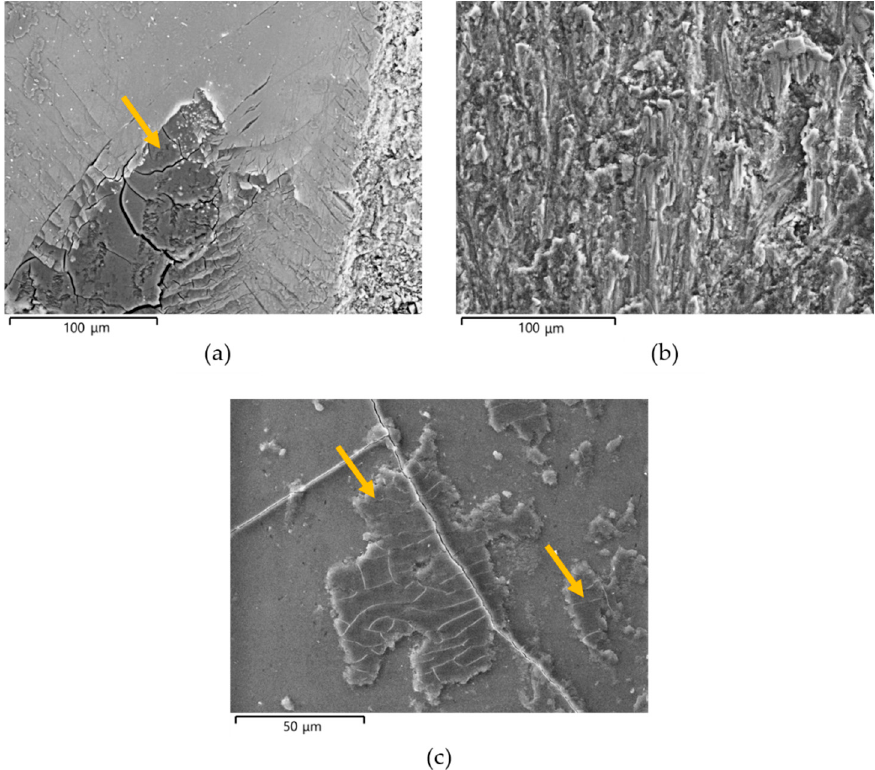
Figure 10. VPSEM images of the worn surfaces of pins after wear tests: ( a ) details of the original surface with metallic film deposition on G_50; ( b ) details of abrasion of the aluminum substrate in GP_50; ( c ) details of metal transfer and microcracks on G_100. In ( a ) and ( c ), the orange arrows indicate the tribofilm on the wear tracks, consisting of well-adherent, compacted, and plate-shaped wear particles.